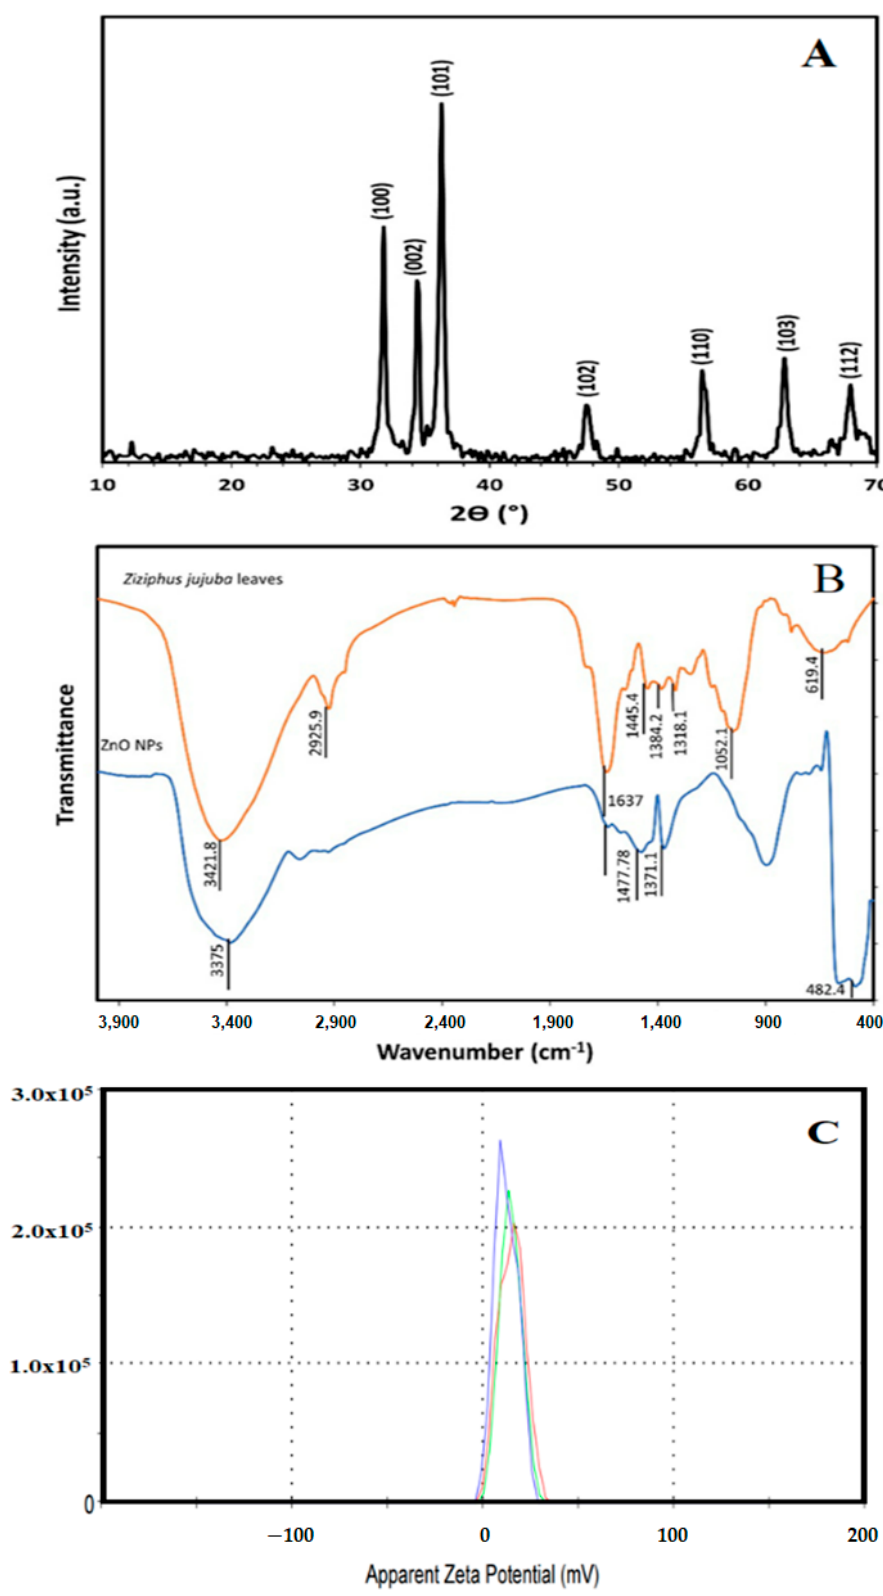
Figure 1. X-ray diffraction pattern of green biosynthesized ZnO NPs ( A ), FT-IR spectra of Ziziphus jujuba leaves extract and green biosynthesized ZnO NPs ( B ), and the zeta potential measure- ment of the green biosynthesized ZnO NPs ( C